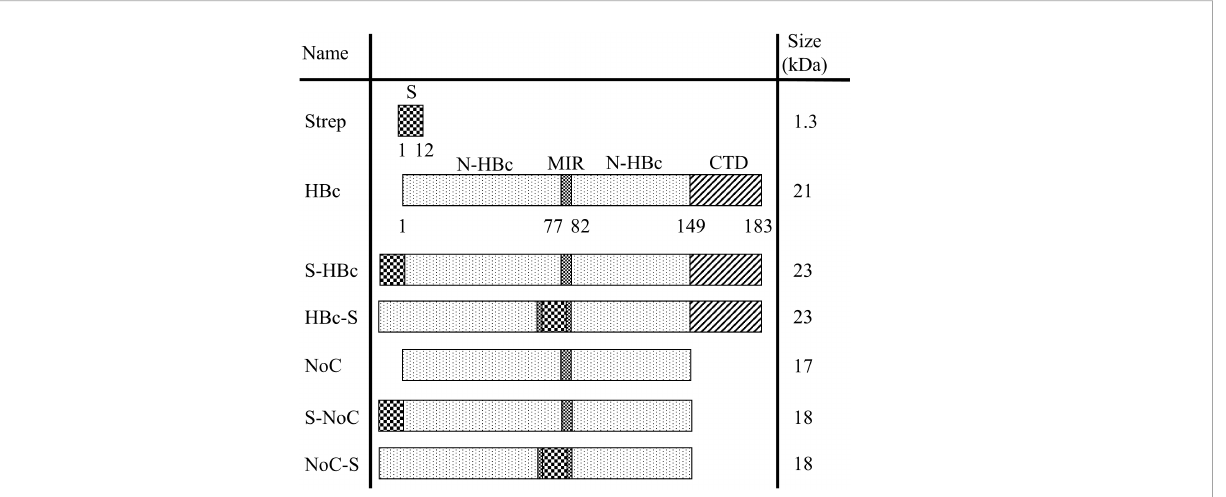
FIGURE 2 Overview of the HBc constructs used in this study. Schematic representation of the genetic constructs used to express the different HBc VLP variants in BYL. All constructs were cloned into the pALiCE01 BYL expression plasmid. The numbers under the construct indicate the amino acid position for each domain. N-HBc, N-terminal domain of the HBc monomer; MIR, major insertion region; CTD, C-terminal domain; Strep, strep-tag II insert with the GSWSHPQFEKGS